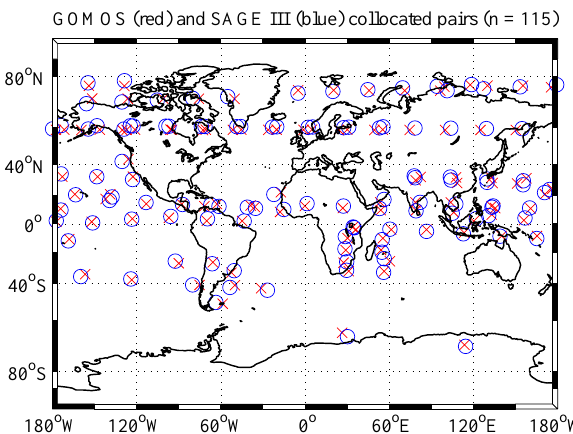
Fig. 3. Spatial distribution of 115 collocated GOMOS-SAGE III pairs (red cross and blue ring) from the years 2002–2004.